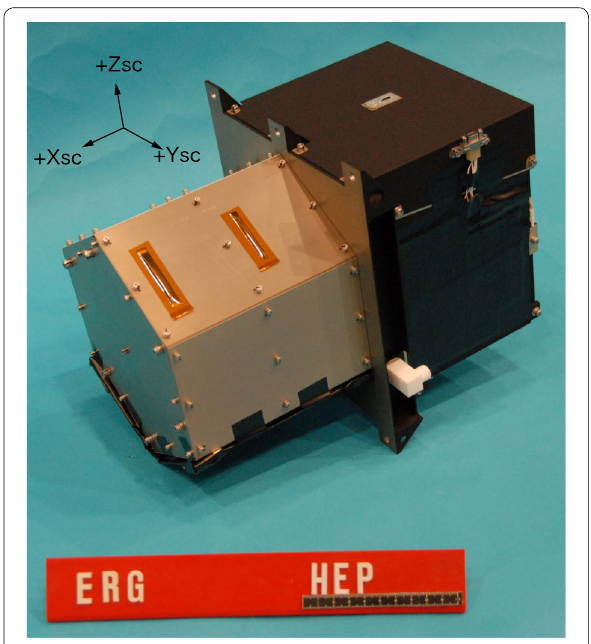
Fig. 1 Photograph of HEP flight model. The marked axes are the satellite coordinates shown in Fig. 2. In the left part of the figure, it can be seen that the hexagonal cylinder houses three HEP-L modules and three HEP-H modules. Electronics boards are housed in the black box shown in the right part of the figure. Each of the three sides of the hexagonal cylinder includes two cutouts through which the electrons enter the HEP-L/HEP-H